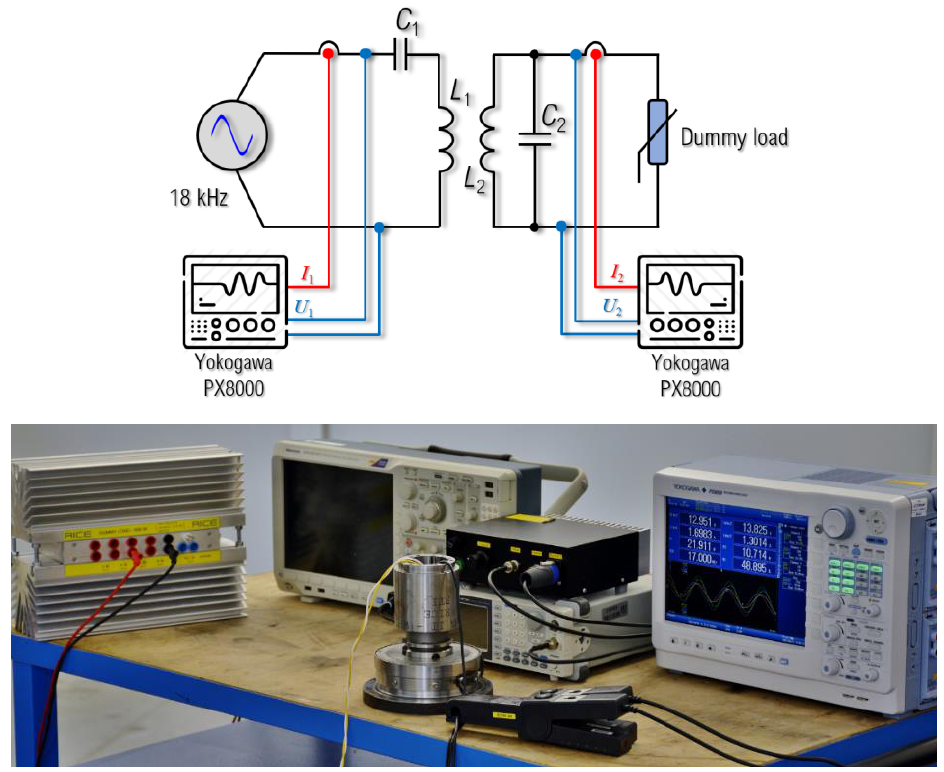
Figure 6. Laboratory set up for experimental measurements: test rig ( bottom ) and principal schematic ( top ).